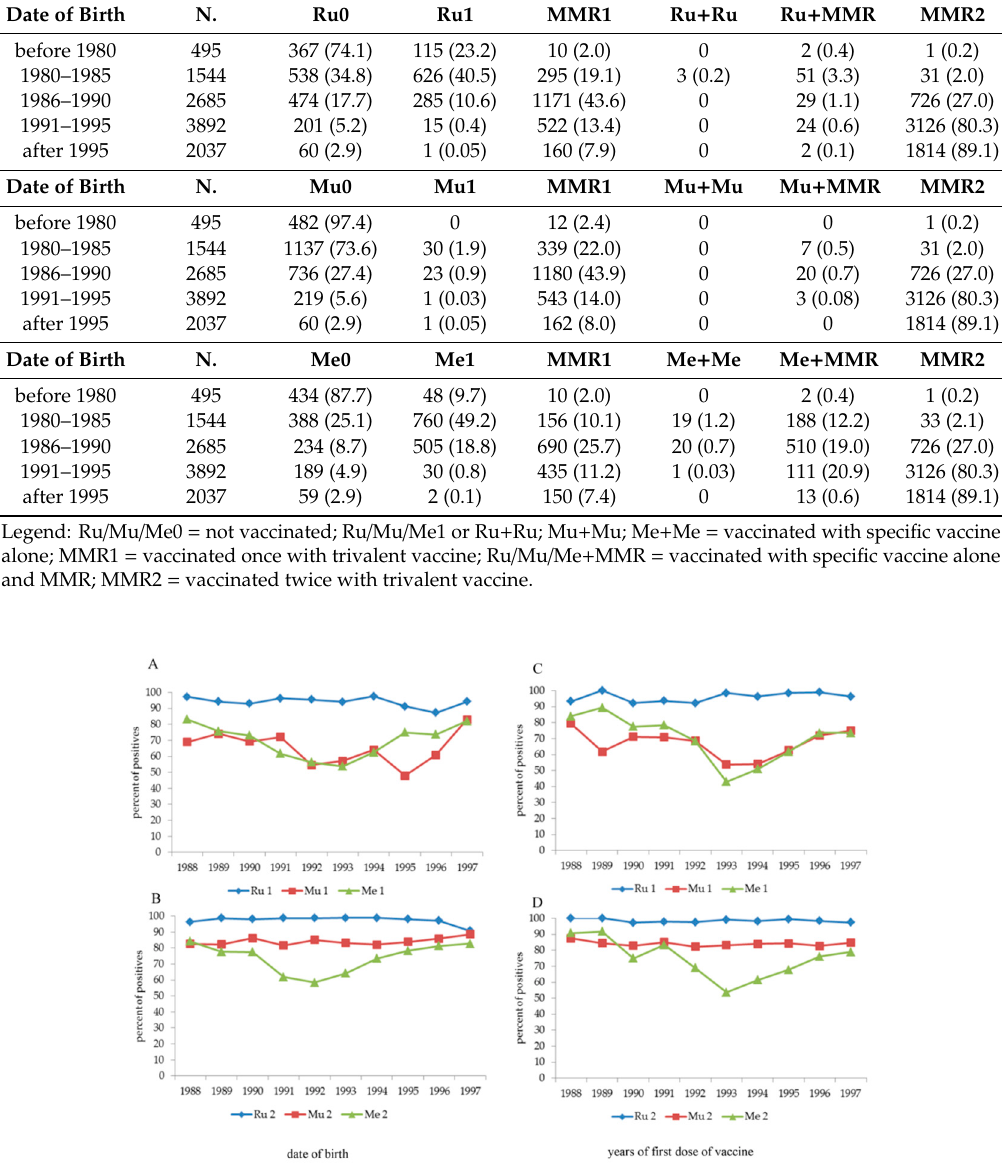
Figure 3. Percentage of positive antibodies against Ru, Mu and Ru after one or two doses of vaccine according years of the date of birth ( panel A , B ) and the 1st dose of vaccine ( panel C , D ) in students born between 1988 and 1997.